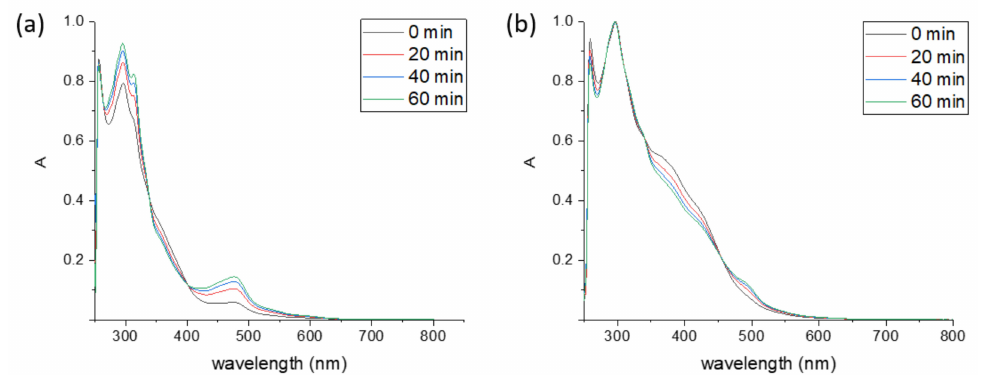
Figure 3. Time-evolution of UV-vis absorption spectra during 1 h without irradiation of ( a ) [RuT0B0(NO)] 3 + and of ( b ) [RuT1B0(NO)] 3 +